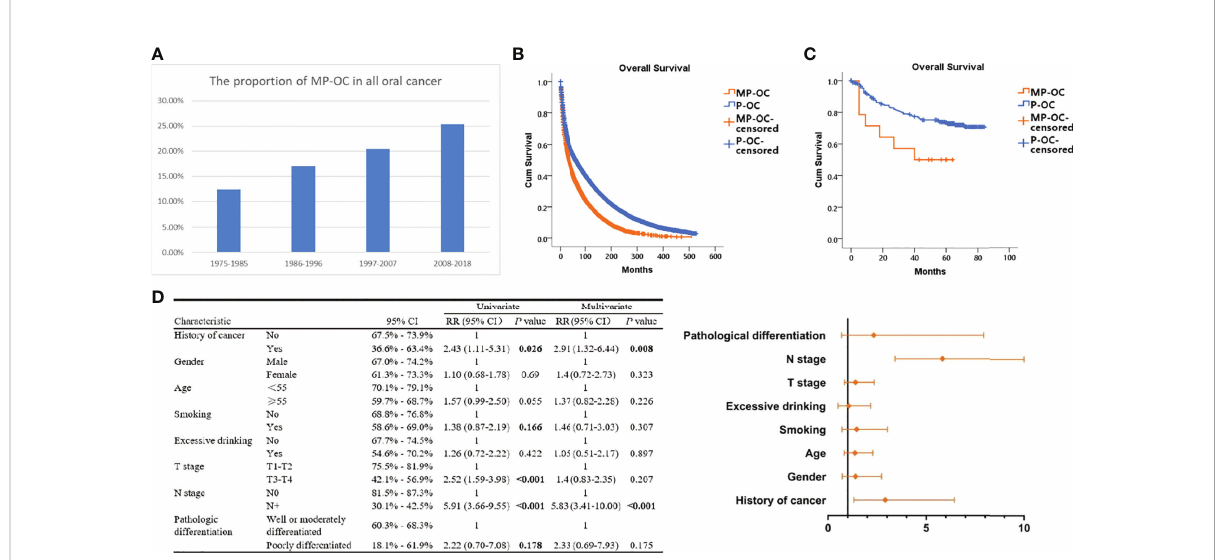
FIGURE 1 Proportion and prognosis of MP-OC and P-OC patients. Histogram of MP-OC patients ’ proportion with years (A) . Overall survival of MP-OC and P-OC patients from the SEER database. Kaplan – Meier survival analysis, p < 0.001 (B) . Overall survival of matching 16 MP-OC patients and 301 P- OC patients from the Hospital of Stomatology, Sun Yat-sen University. Kaplan – Meier survival analysis, p = 0.03 (C) . Univariate regression analyses and multivariate Cox regression analysis of OC patients (D)